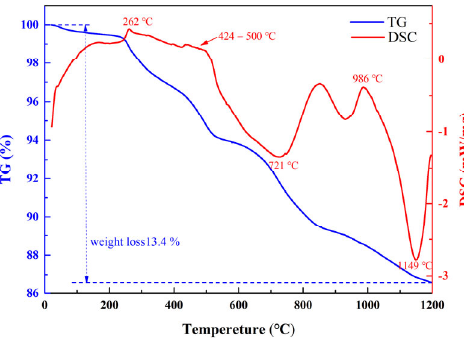
Figure 17. TG-DSC curve of C10-D90